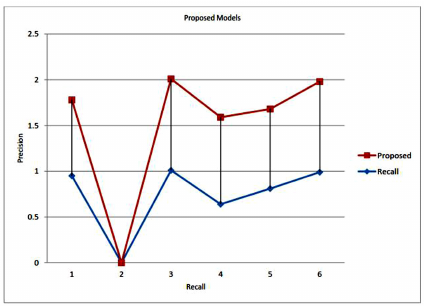
Figure 5. Comparison of Transitivity Outcomes in proposed